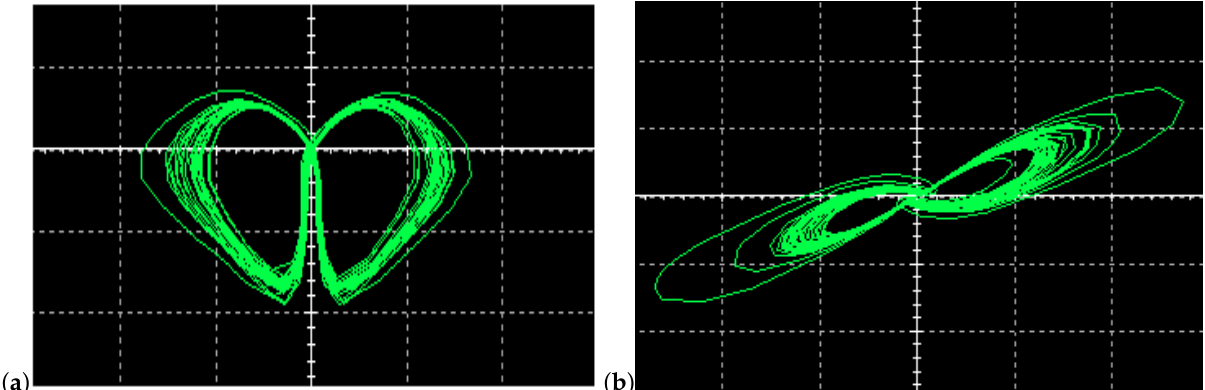
Figure 18. Phase portraits of the circuit from Multisim: ( a ) X - Z plane and ( b ) X - Y plane.